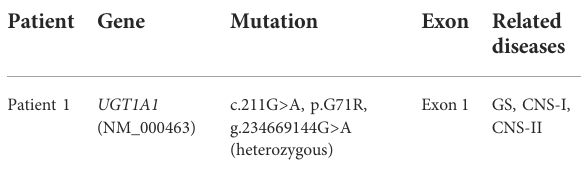
TABLEA2Otherbilirubin-metabolism